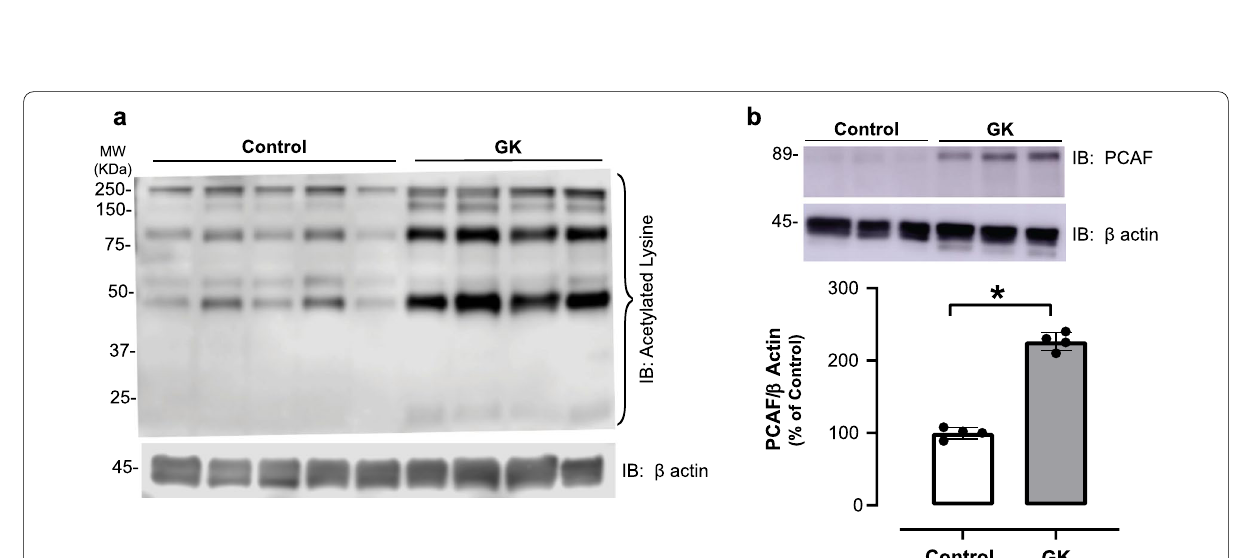
Fig. 4 Lysine acetylation and PCAF expression is increased in aortas from GK rats in advanced T2DM. a Global lysine acetylation was detected by using a specific antibody for acetylated lysine residue. β actin used as internal control. b Representative immunoblotting for PCAF (top panel). β actin used as internal control. Bar graphs are means SEM of four independent experiments as determined from densitometry relative to β actin. ± *p < 0.05 vs. control, n 4–5 per =